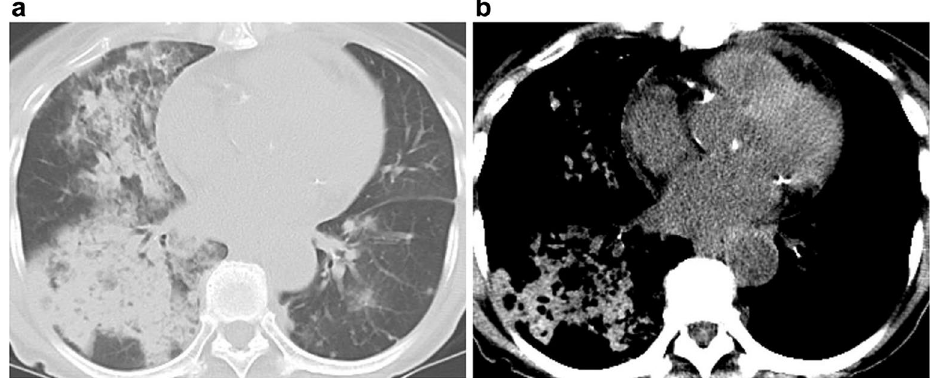
Figure 1. 70-year-old woman with diffuse alveolar hemorrhage in microscopic polyangiitis. ( a ) Transaxial CT with a lung window setting showing consolidation in the right lung. ( b ) Hyperdense consolidation is shown with a narrow window setting and a mediastinal